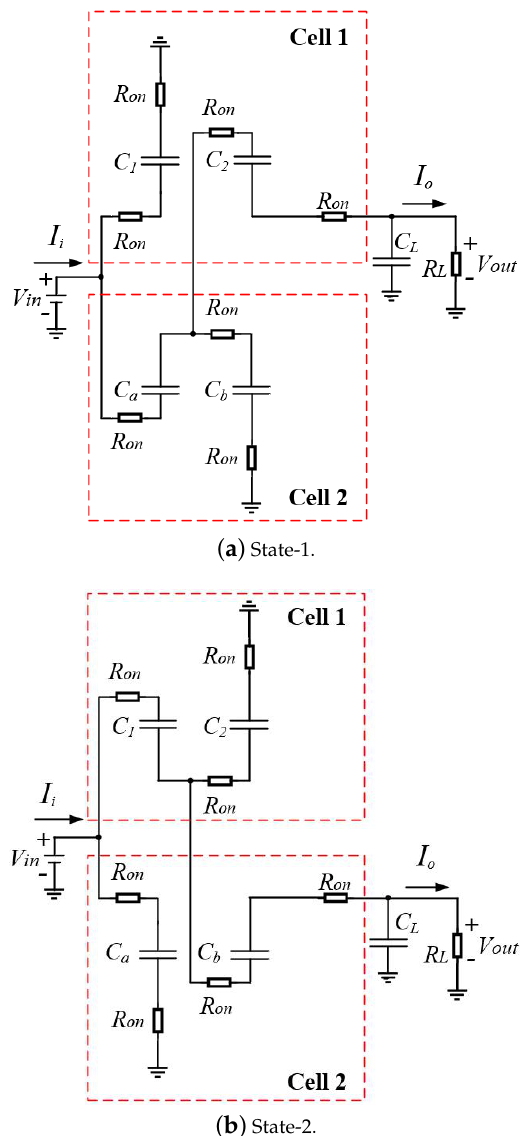
Figure 3. Instantaneous equivalent circuits in steady state during one operating